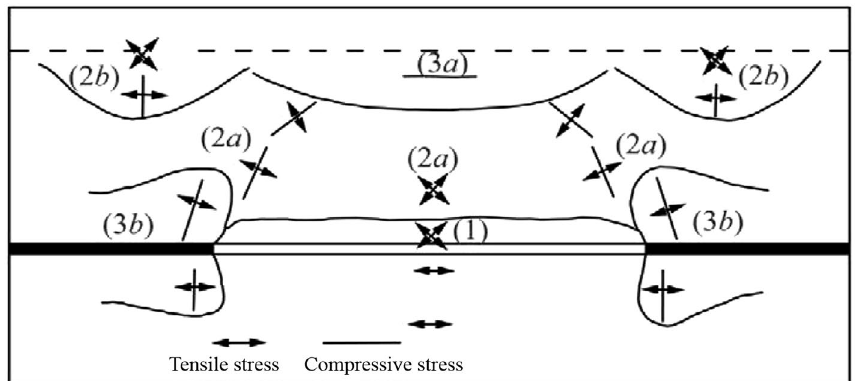
Figure 7. The stress redistribution around longwall face 42 . 1—Tensile stress zone above the goaf; 2a— Tensile and compressive stress zone above the goaf; 2b—Tensile and compressive stress zone at the top; 3a— Compressive stress zone at the top; 3b—Abutment pressure zone.